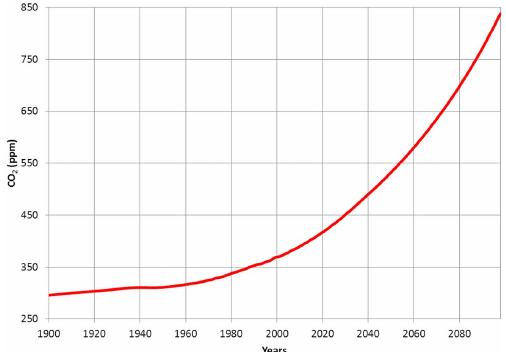
Fig. 3. Trend of CO 2 (ppm) according to SRES A2 scenario plotted from the beginning of the 20th century to the end of the 21st